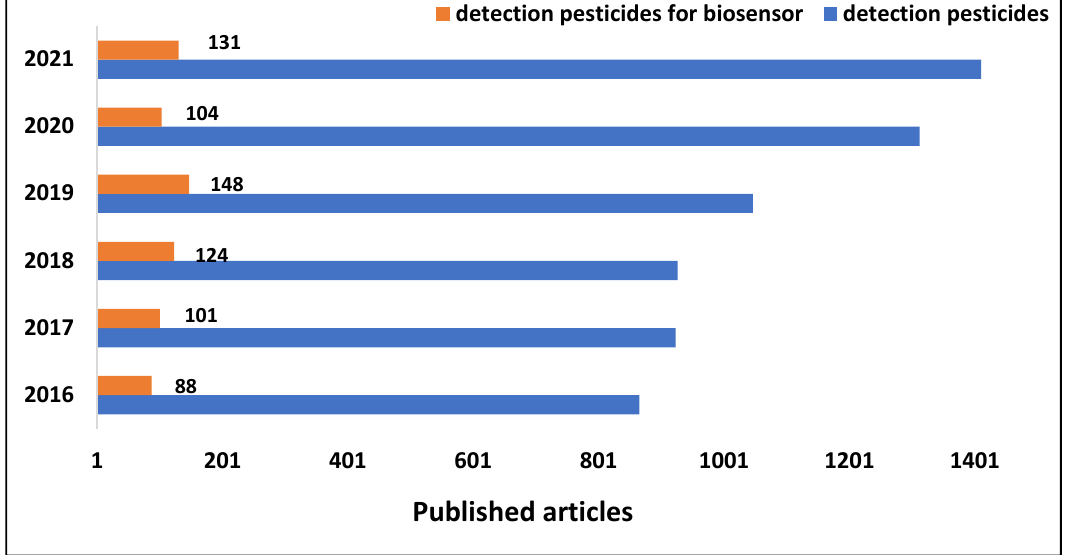
Figure 1. Published articles in the database Web of Science to detect pesticides in the years 2016–2022 as of May 25. Foam search strings: biosensor AND food AND (agrochemical OR pesticides), restricted only to original search articles.